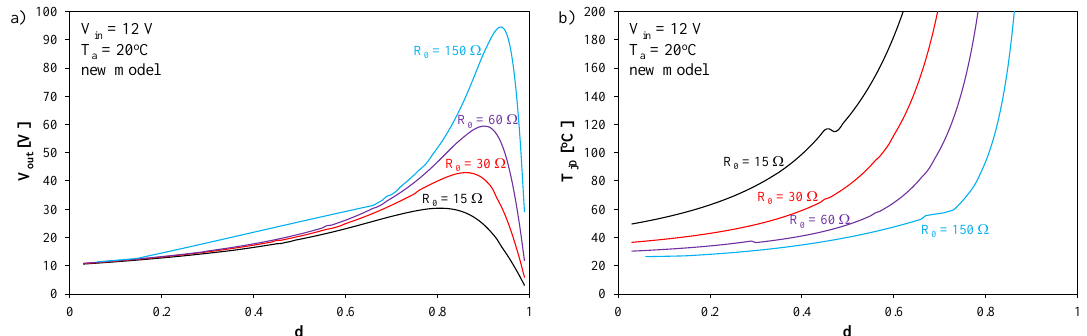
Figure 18. Computed dependences of converter output voltage ( a ) and internal temperature of the diode ( b ) on duty cycle for selected values of load resistance.